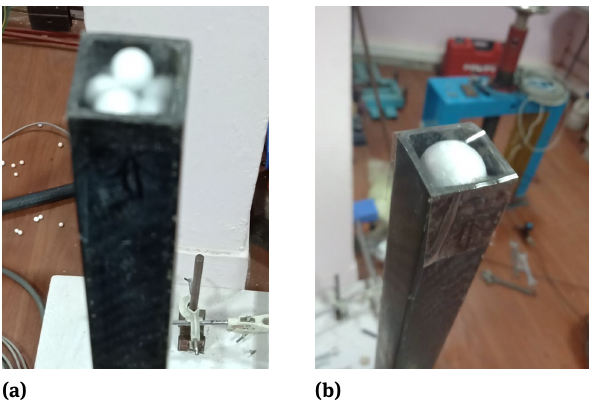
Figure 3: Top view of the tube filled with (a) 9 mm and (b) 18 mm diameter foam balls